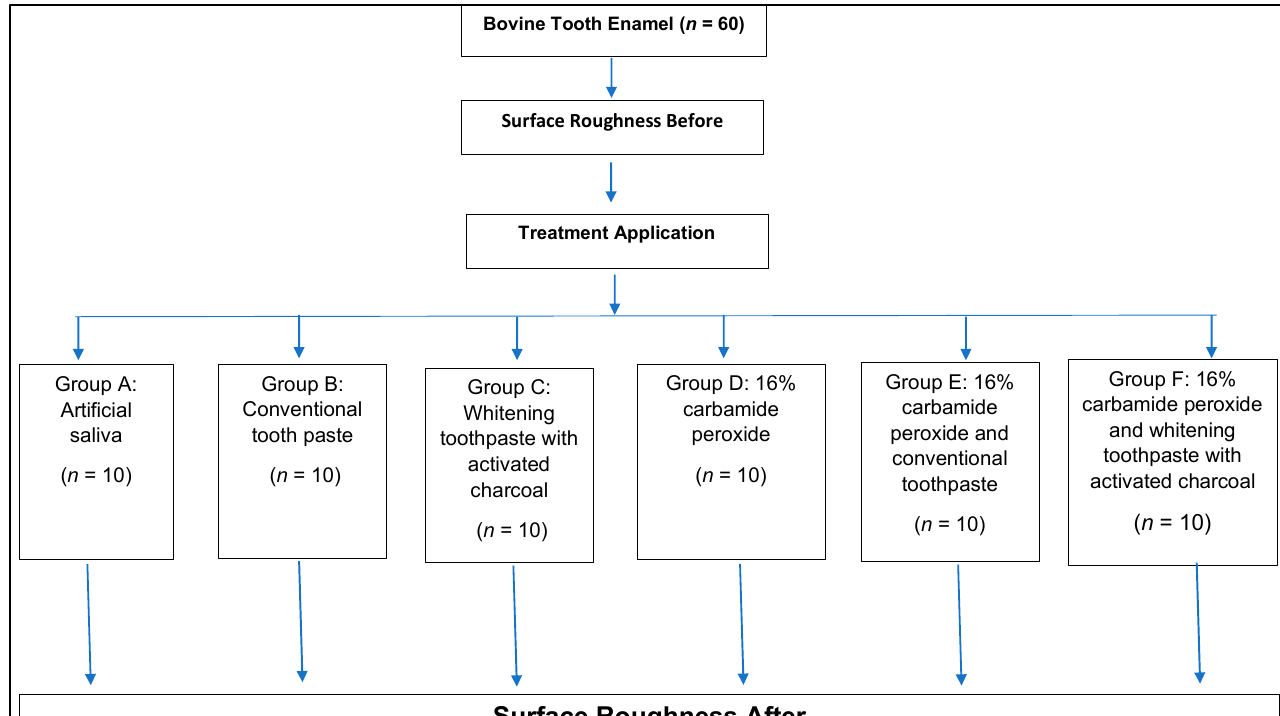
Figure 1. Random distribution of groups, according to sample size.